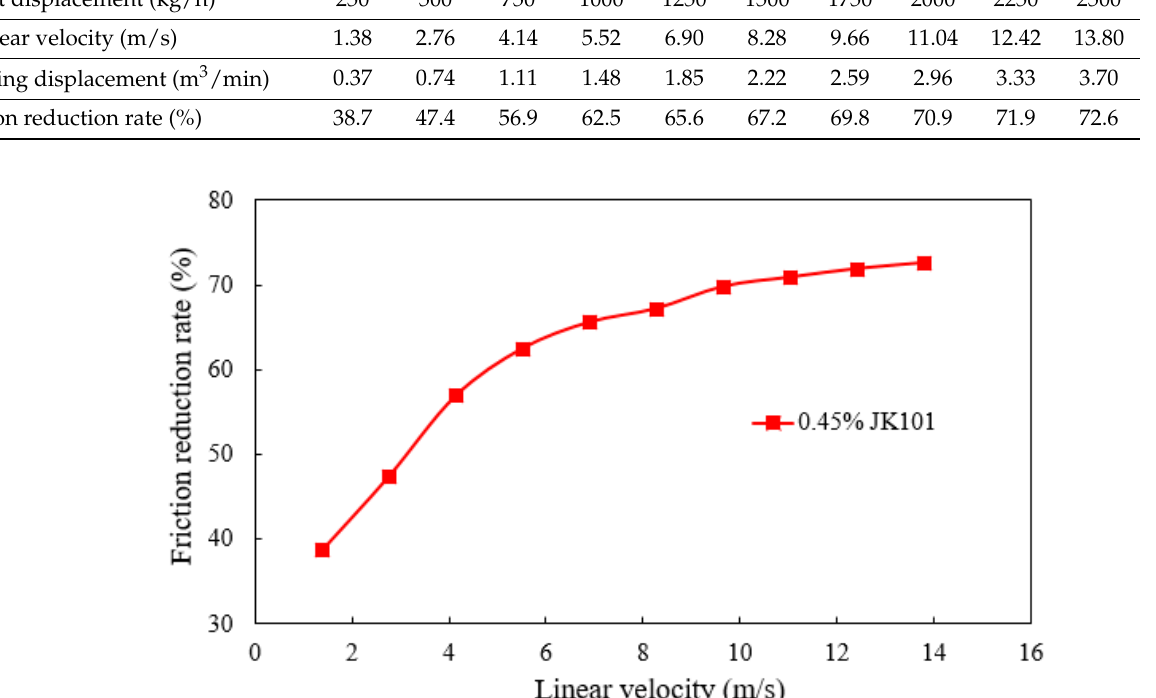
Table 7. Summary table of displacement, linear velocity, and friction reduction rate.